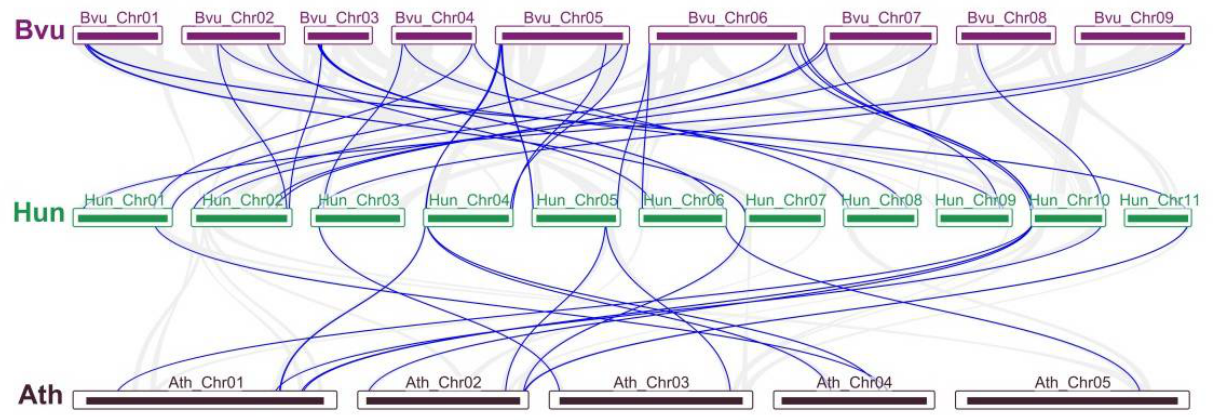
Figure 4. The synteny analyses of WRKY genes between H. undatus , A. thaliana , and B. vulgaris . Gray lines indicate all synteny blocks in the genome, and the blue lines indicate the duplication of gene pairs.